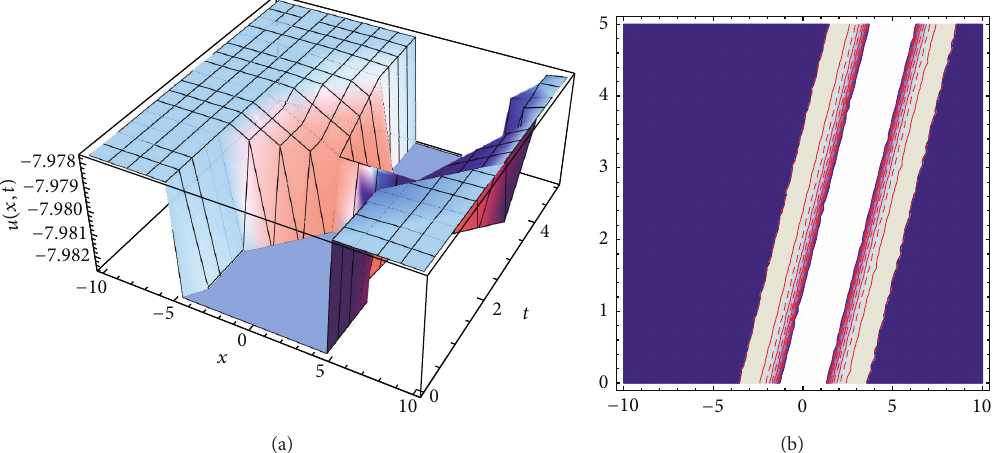
Figure 1: (a) Travelling waves solutions of (11) is plotted: stability dark solitary waves. (b) Travelling waves solutions of (11) is plotted: stability contour of solitary